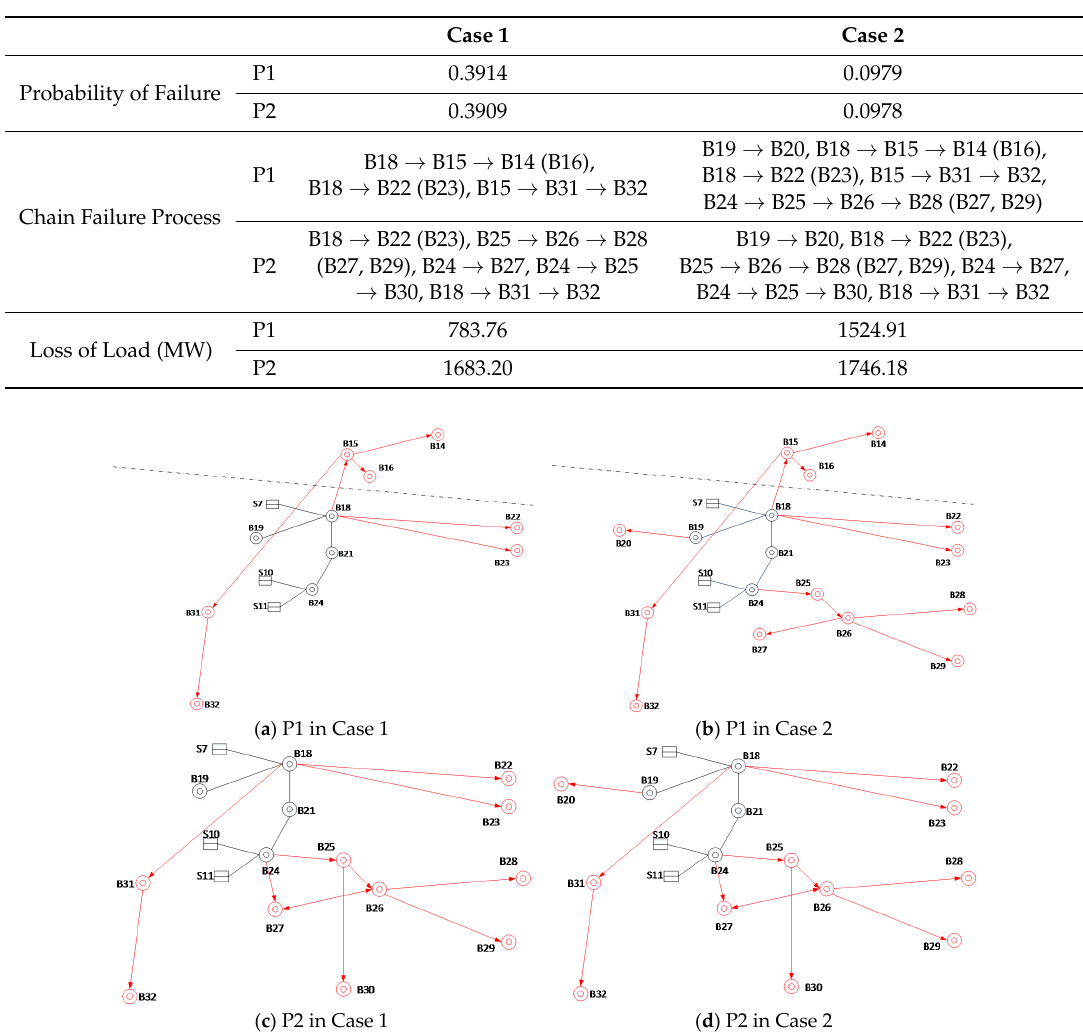
Figure 7. The development of cascading faults. ( a ) P1 in Case 1; ( b ) P1 in Case 2; ( c ) P2 in Case Table 2. Simulation results.